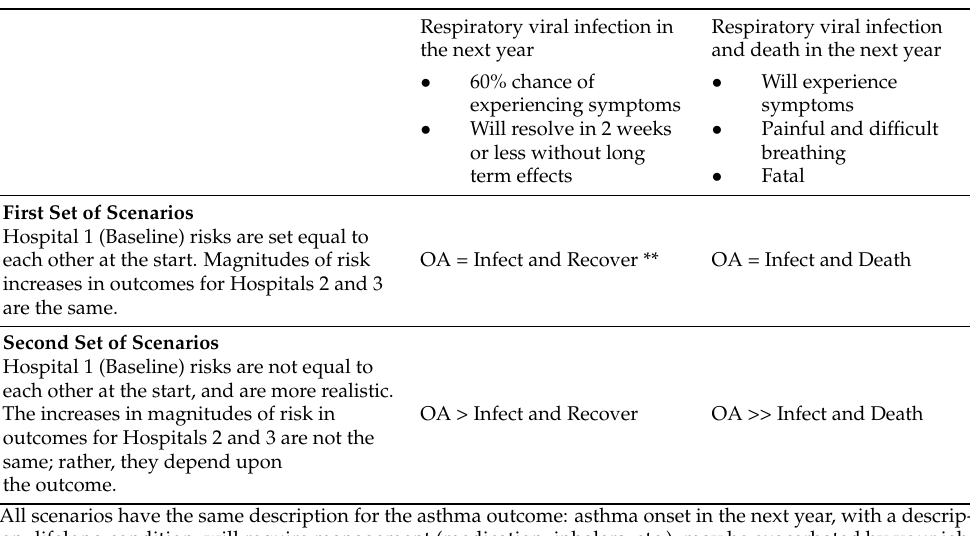
Table 2. Survey scenario descriptions